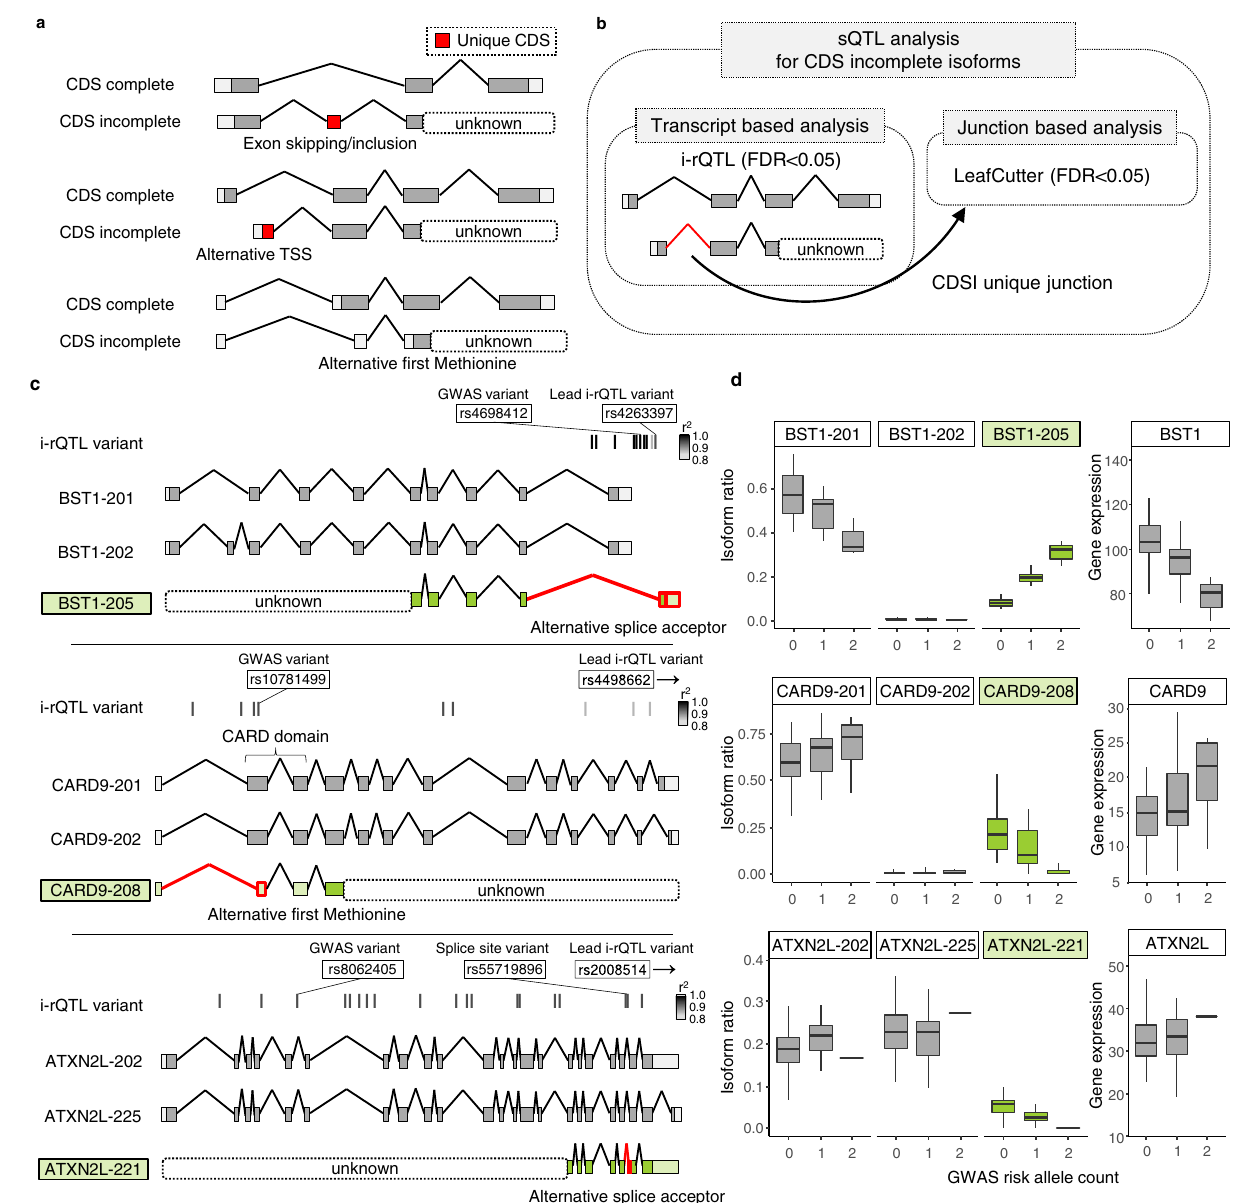
Fig. 4 | sQTL analysis for CDS incomplete isoforms. a Examples of CDS incom- plete isoforms with and without unique CDS. b sQTL analysis for CDS incomplete isoforms. c Gene models of the major isoforms of BST1 , CARD9 and ATXN2L . BST1- 205 , CARD9-208 and ATXN-221 have incomplete CDS. d Boxplots of i-rQTL effects